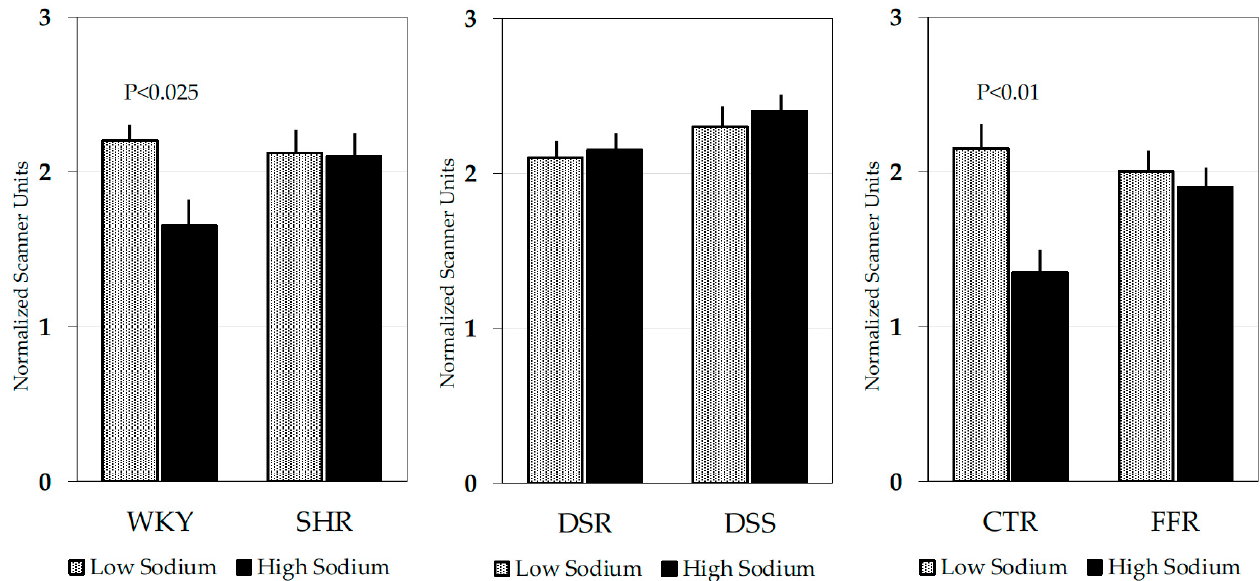
Figure 2. Bar graphs showing mean ± standard error of insulin receptor mRNA in total kidney extracts that were obtained in separated experiments from Wistar-Kyoto (WKY) and Spontaneously Hypertensive (SHR) rats; Dahl salt-resistant (DSR) and Dahl salt-sensitive (DSS) rats; Control (CTR); and Fructose-fed (FFR) rats. Rats were fed low-sodium (shaded bars) or high-sodium (black bars) diets for 2 weeks. Optical density was determined on Northern blots and is expressed as scanner units normalized for 28S ribosomal RNA. In WKY and Control rats, the high-sodium diet induced a significant decrease in insulin receptor gene expression that was not found in SHR and FFR rats.